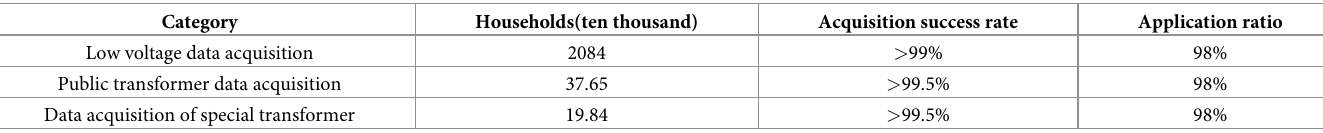
Table 7. Data collection of various